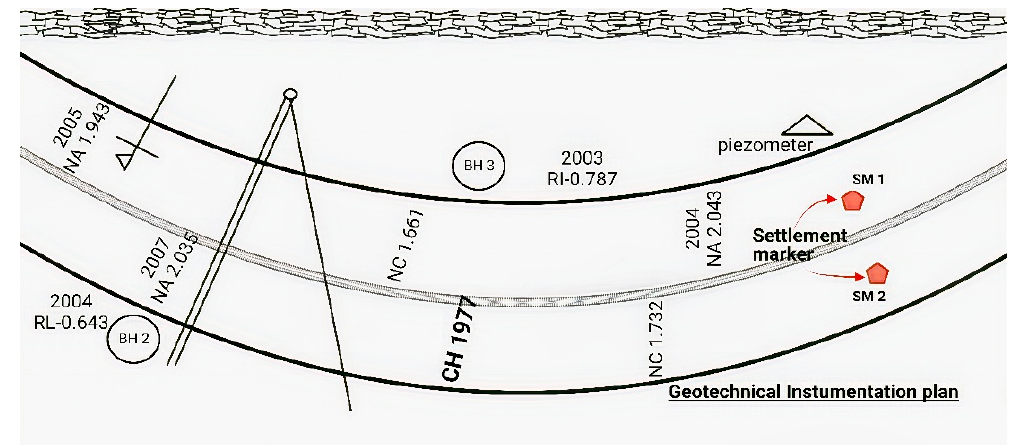
Figure 2. Instruments installation plan in CH 1977.